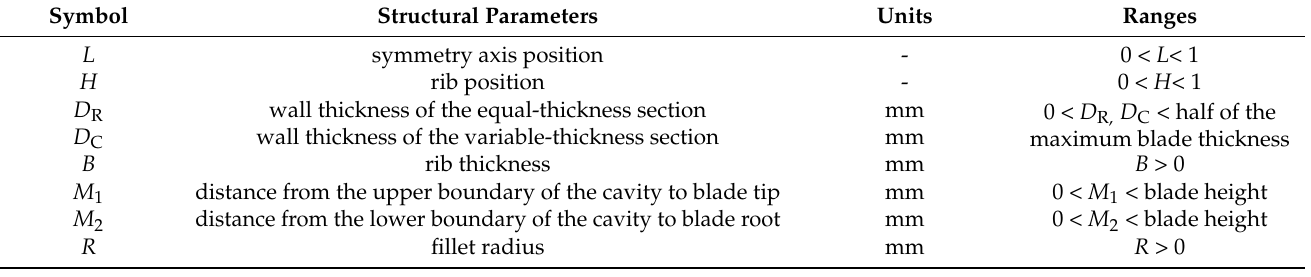
Table 1. Structural parameters of hollow fan blade.